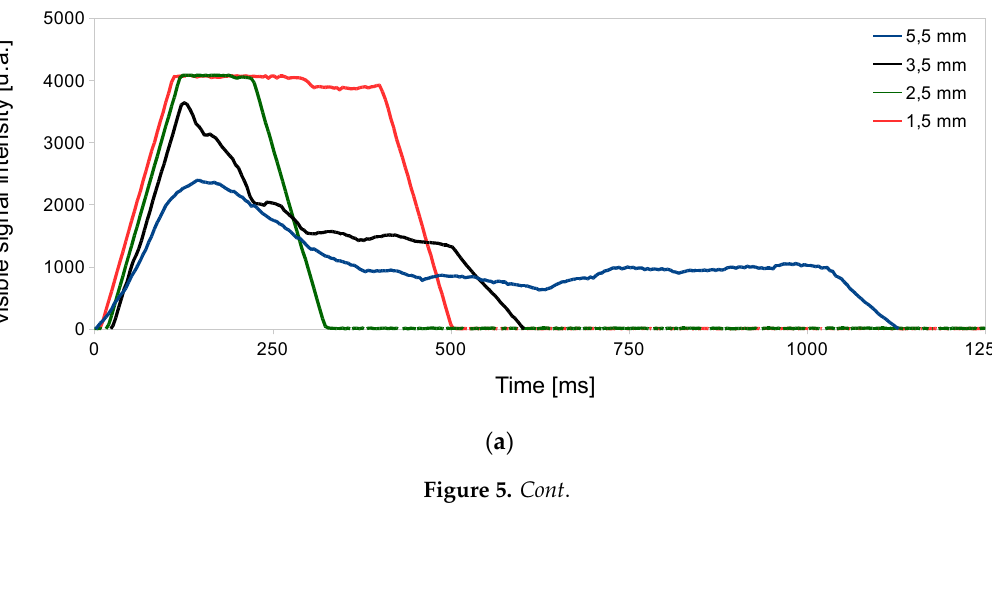
Figure 4. Piercing monitored signal for stainless steel 10 mm thick, varying ( a ) focal position; ( b ) standoff; ( c ) duties percentage; ( d ) frequency. The ideal parameters are shown in black. Red and green parameters pierced the sheet with longer duration.